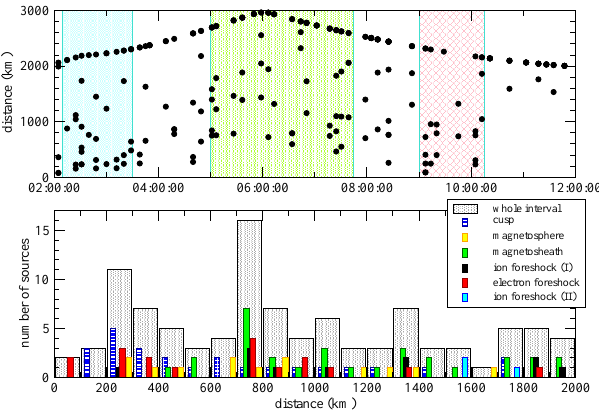
Fig. 9. Distances to the sources. Top panel: distances to the wave sources for all detected sources during the interval. Bottom panel: Histogram of the distances to the sources for the entire data interval and for specific